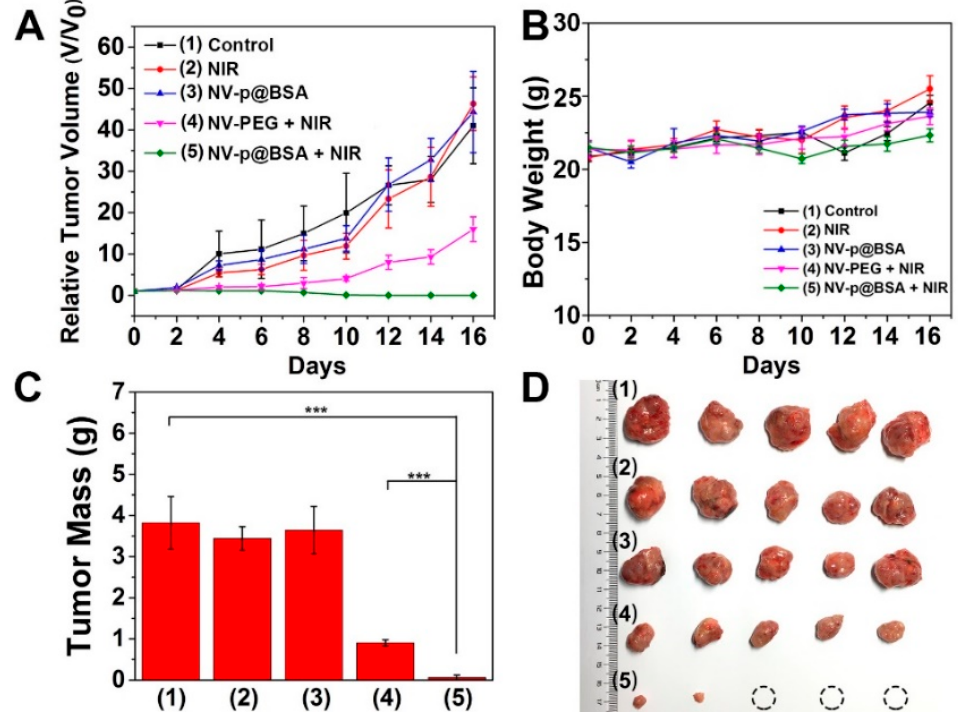
Figure 5. ( A ) Relative tumor volume changes and ( B ) corresponding body weight changes of tumor- bearing Balb/c mice after different treatment processes, as indicated. ( C ) Average weights of tumors collected from mice in each treatment group. ( D ) Photos of representative excised tumor tissues from different groups of mice at the end of treatments. p -values: *** p < 0.001.